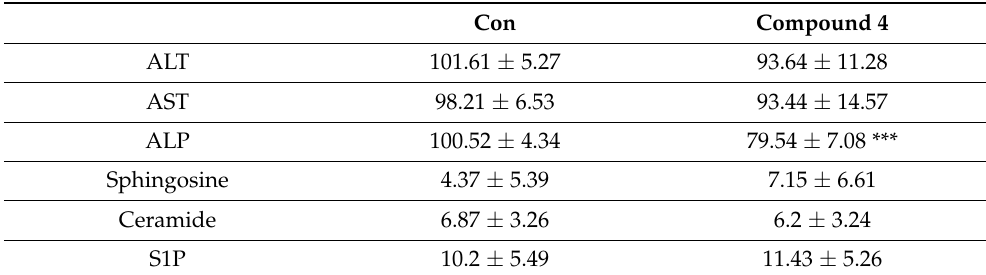
Table 3. Change of blood chemistry in tumor xenograft mice for 29 days treated with vehicle and Compound 4